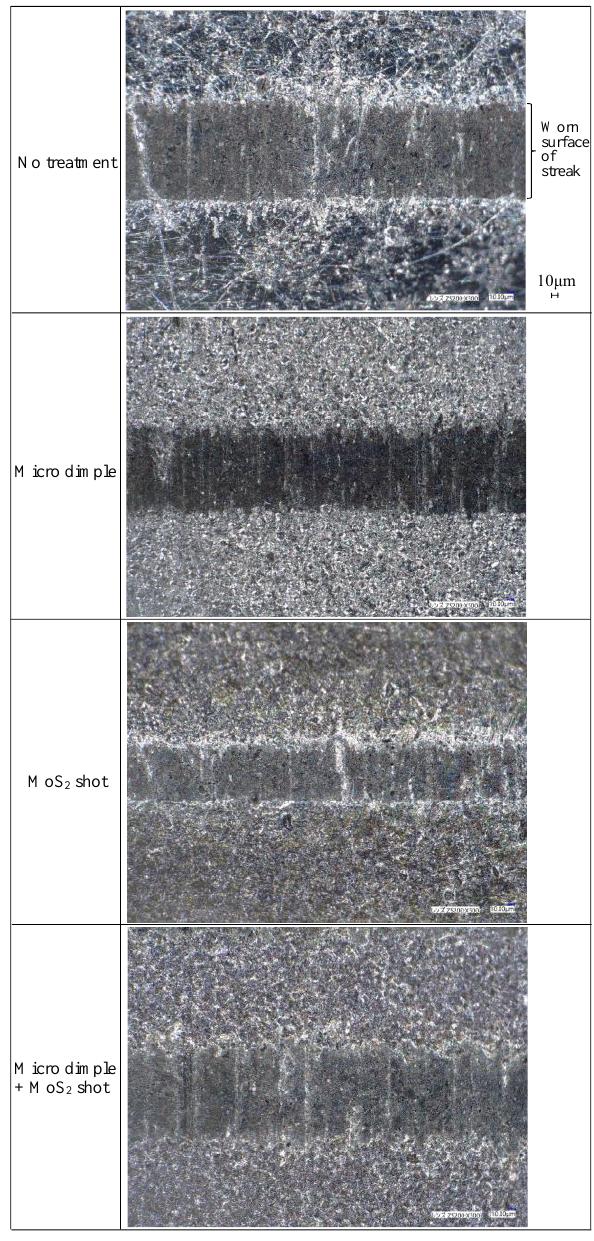
Fig. 15. Observation results of streaked surface at piston skirt “C” at anti- thrust side after friction